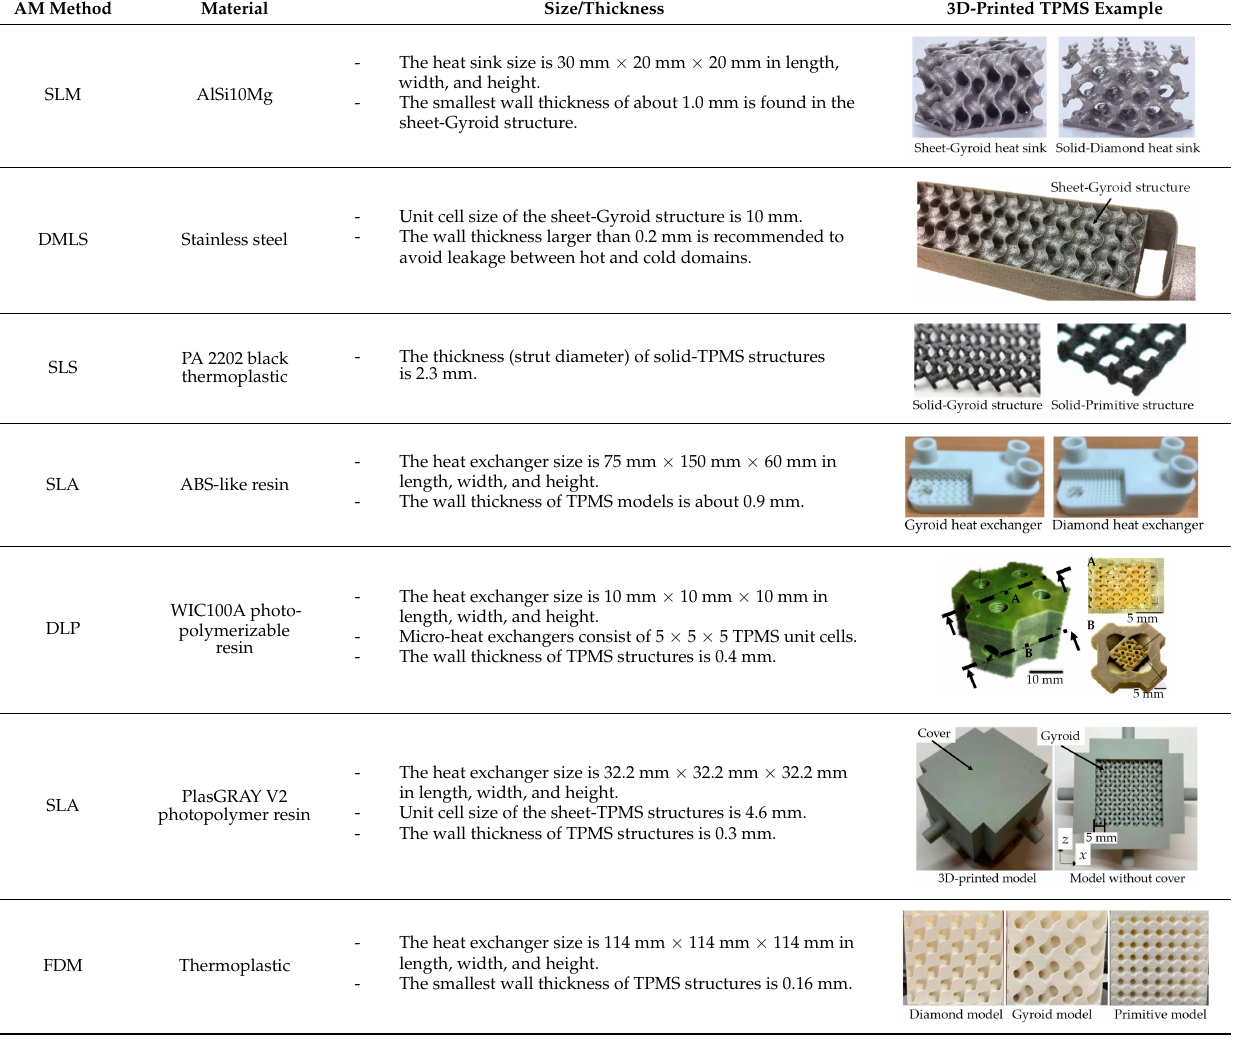
5. Recommendations for Future Research According to the literature review, the effects of porosity and wall thickness